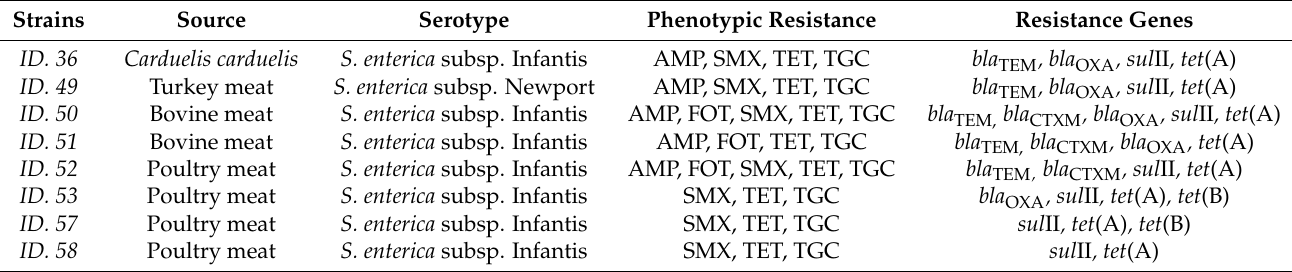
Table 3. Genotypic and phenotypic resistance results.